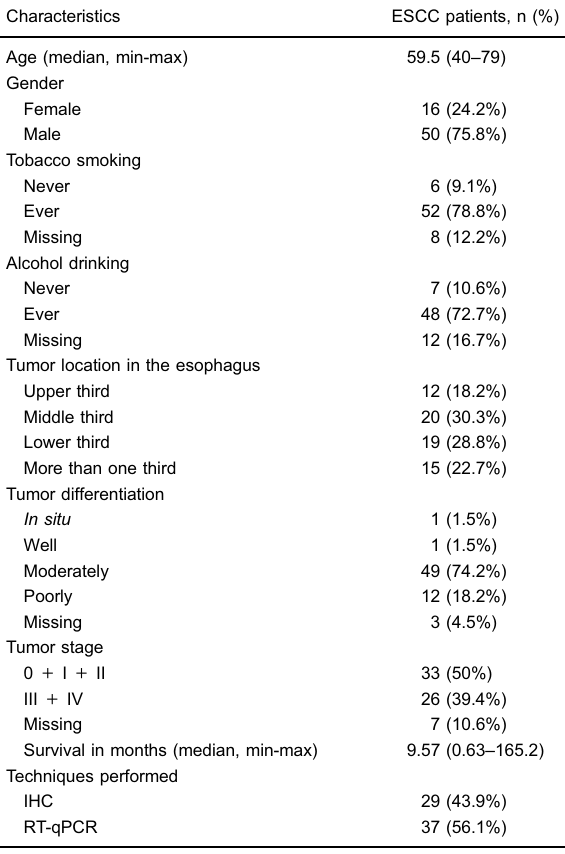
Table 1. Social-demographic and clinical-pathologic character- istics of the esophageal squamous cell carcinoma (ESCC) cases included in the